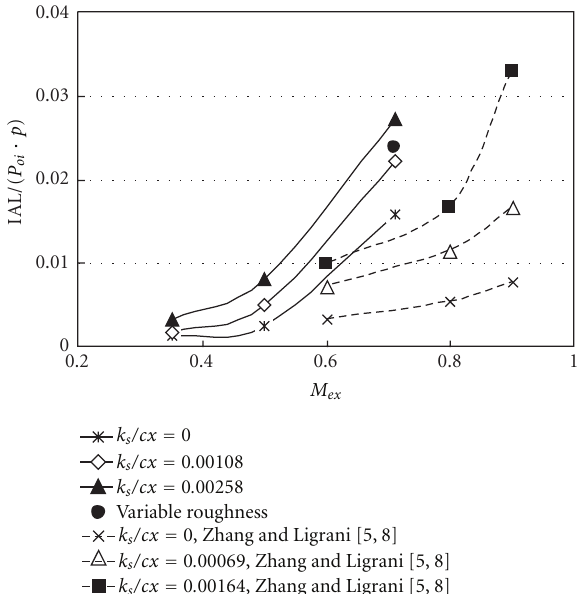
Figure 19: Comparison of normalized integrated aerodynamic loss magnitudes as dependent upon exit Mach number, and measured one chord length downstream of the cambered and symmetric airfoils, for Tu = 1.1–1.6 percent for a cambered vane [38].